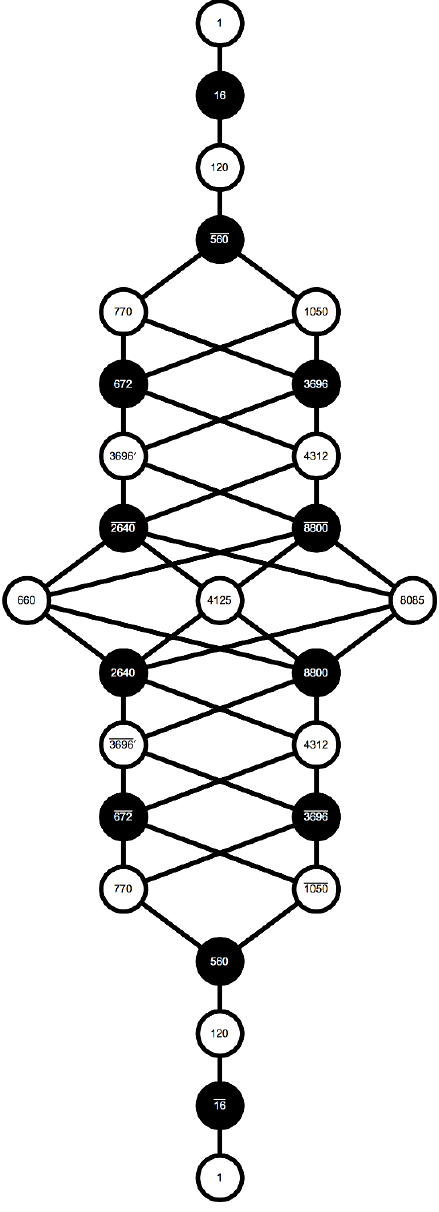
Figure 6 . Adinkra with Dynkin labels indi- cated in